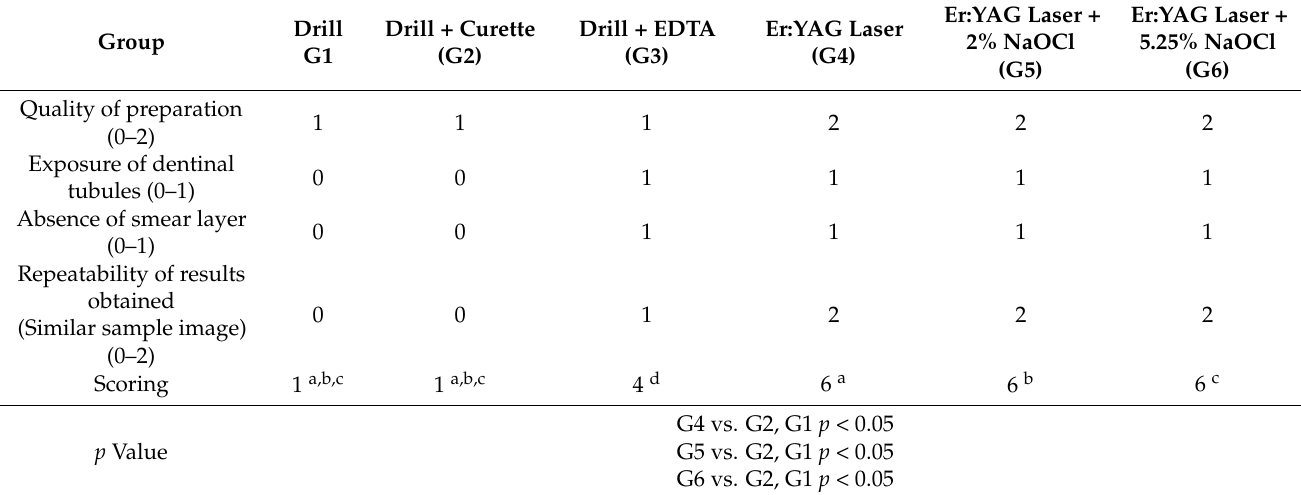
Table 1. The results of semi-quantitative studies concerning samples. Similar small (a, b, c, d) letters in a column indicate statistical significance between groups. ( p <